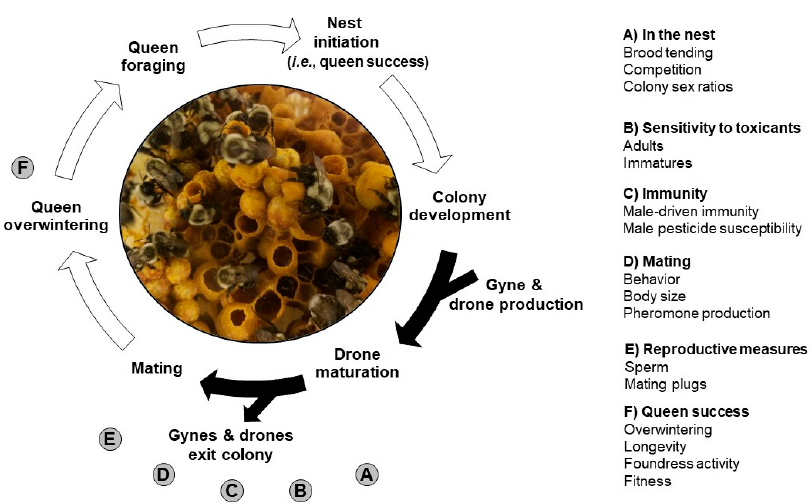
Figure 1. Bumble bee lifecycle and drone contributions to nest success. Bumble bee queens, the only caste to overwinter, emerge in late winter / early spring to begin foraging in order to initiate nests. Arrows indicate the progression of annual nest growth and development. Filled arrows indicate the presence of drones within the nest. Open arrows indicate events that are fulfilled by the queen. Aspects of nest growth, development, and success where drones make important are indicated by letters.